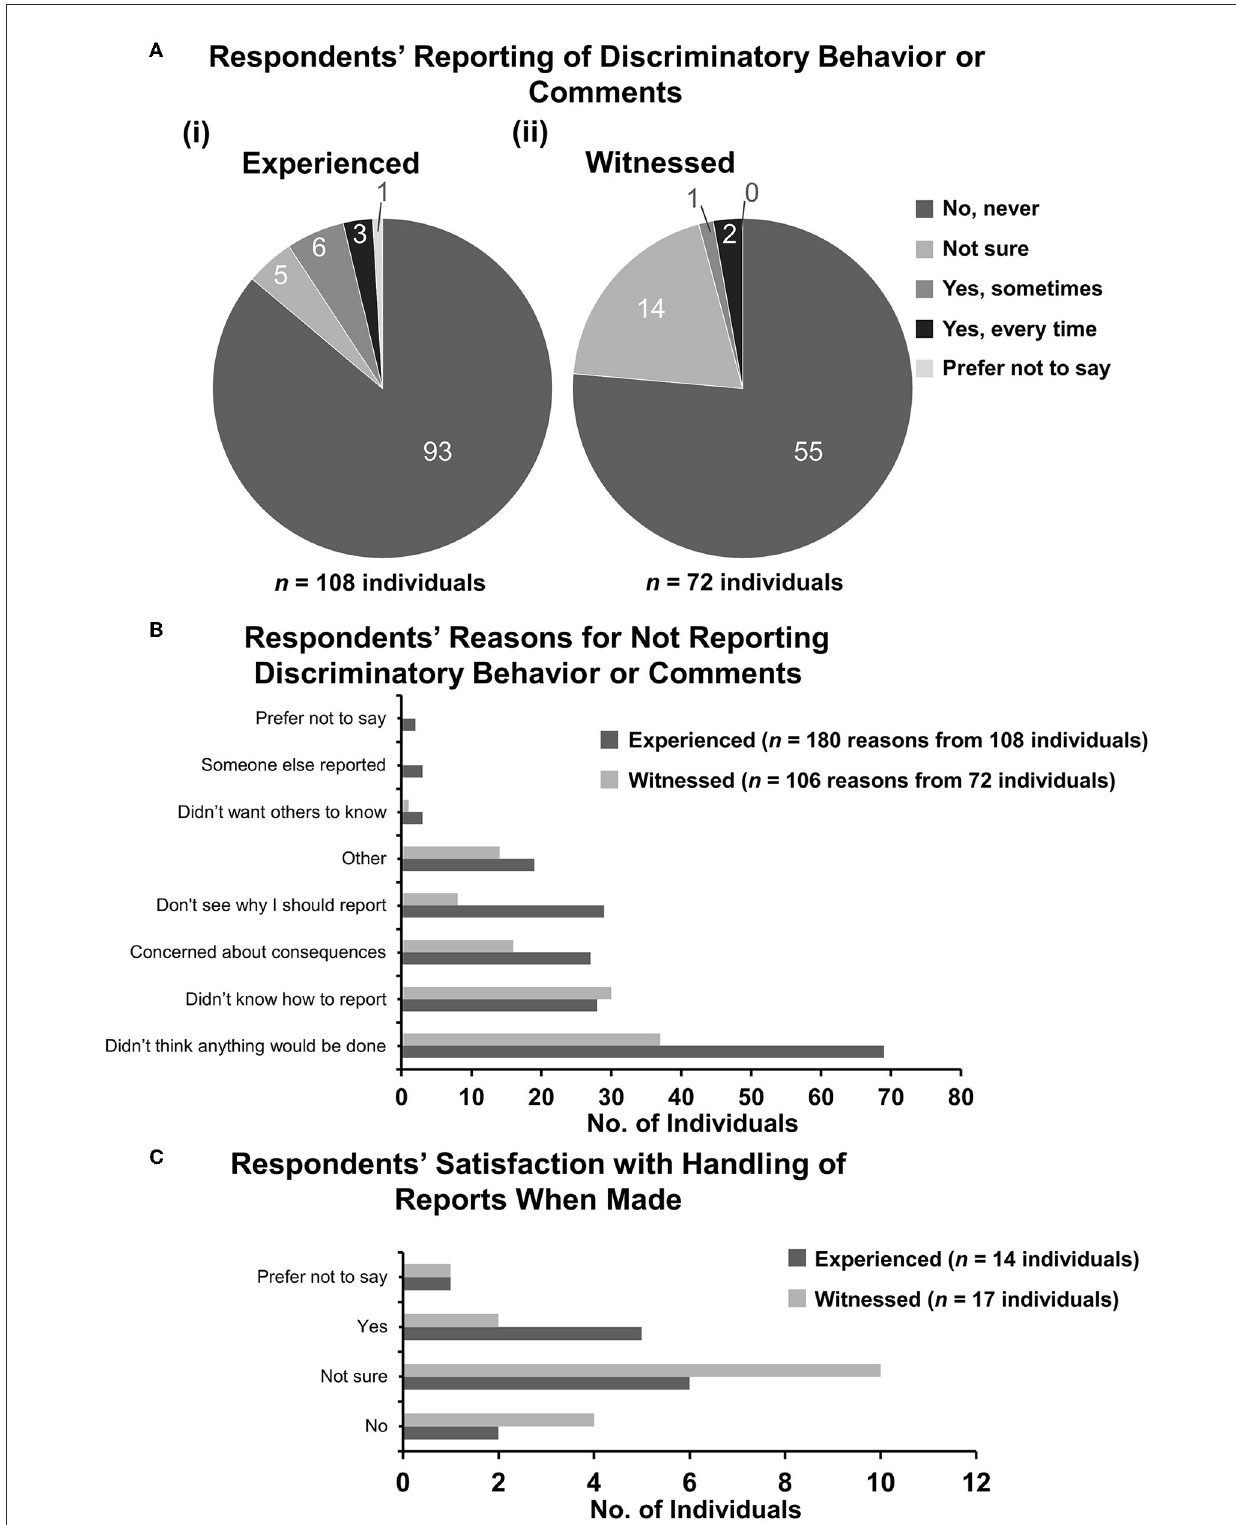
FIGURE5 Respondents’ reporting of discriminatory behavior of comments. Respondents who had responded “yes” or “not sure” were asked whether they had reported the incident(s) experienced or witnessed to anyone. [ (A) i, ii] Pie charts demonstrating the number of respondents selecting each category of reporting for (i) experienced and (ii) witnessed incidents. (B) Bar graph demonstrating reasons selected by respondents who did not report incidents to anyone else. Some respondents had several reasons. (C) Bar graph demonstrating satisfaction of handling of reports when reports were